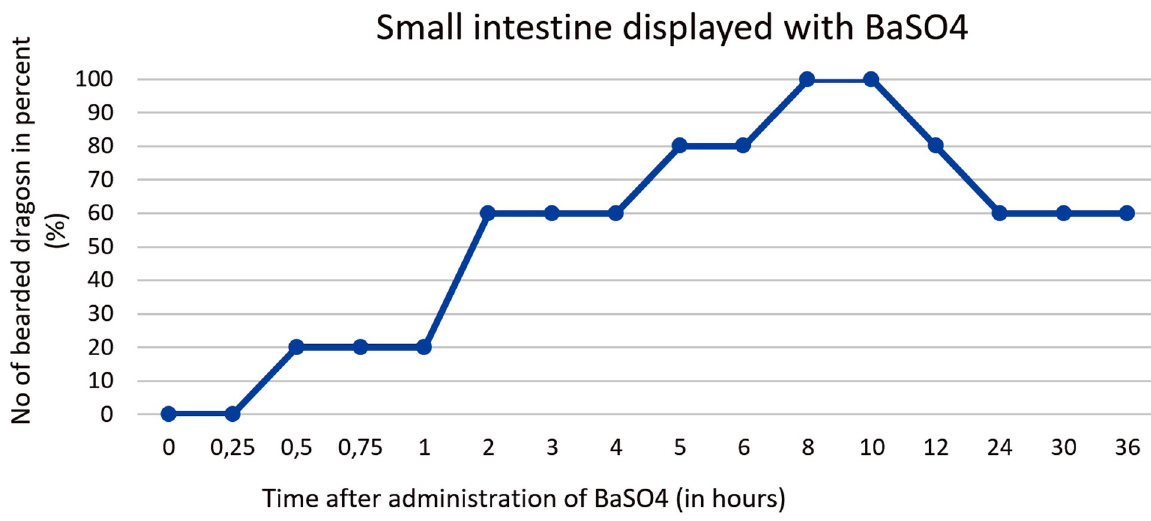
Fig 13. BaSO 4 contrast visibility in the small intestines over time. Percentage of animals and frequency at measuring time point; y = number of animals in percent (%) in which contrast media could be found in the small intestine; x = time point during the BaSO 4 contrast passage (hours).